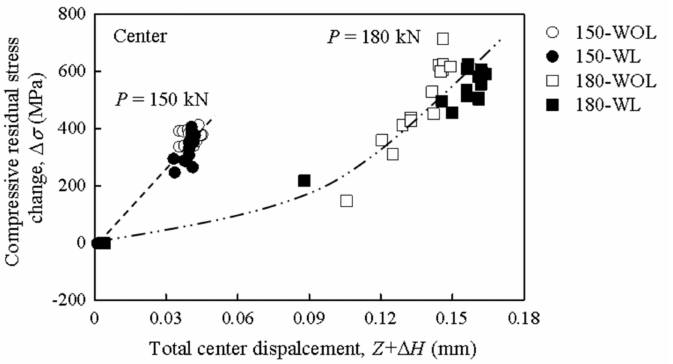
Figure 16. Relationship between the compressive residual stress change and total center displacement. (150 / 180—Forging load (kN), WL—With Lubrication, WOL—Without